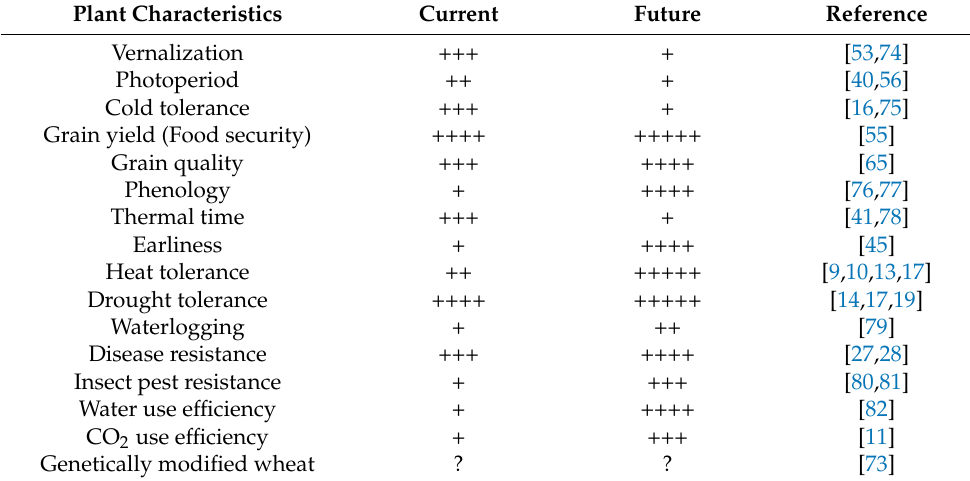
Table 1. Priority rankings of plant characteristics for adapting to climate change in Turkey. Plant